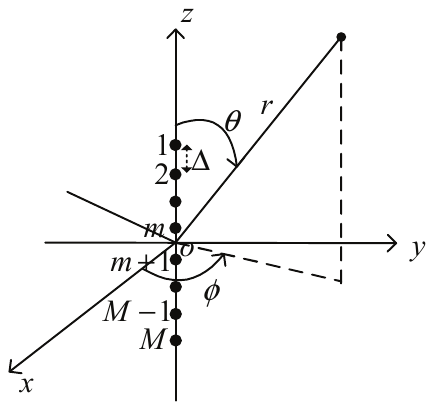
Figure 4. Structure of Uniform Linear Array (ULA) antenna.